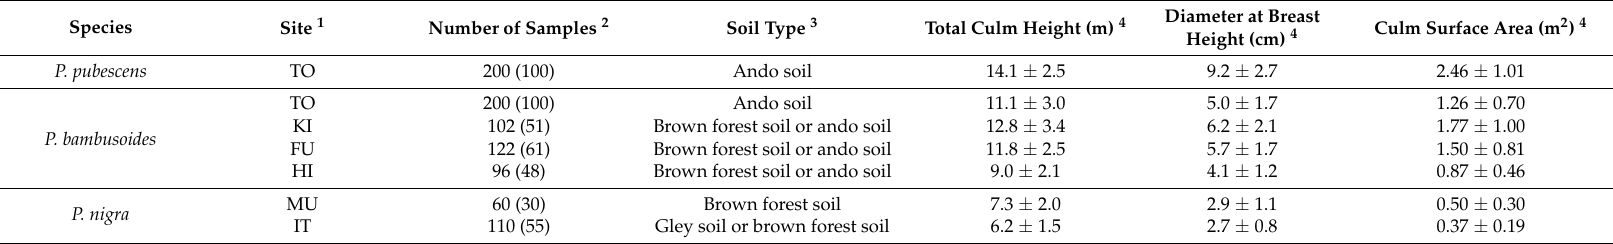
Table 1. Dendrometric parameters of sample culms ( n = 890).